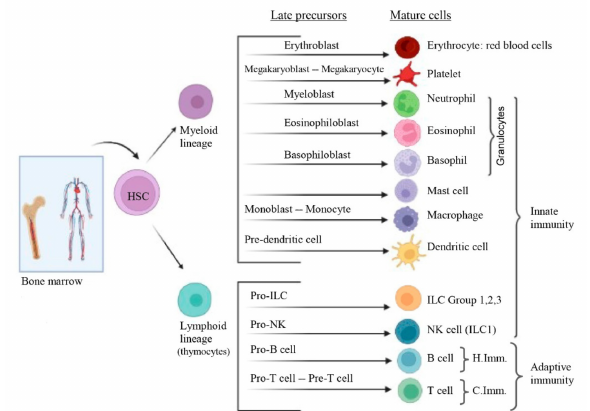
Figure 1. Hematopoiesis. The hematopoiesis process begins with the division of the hematopoietic stem cell (HSC), found in the bone marrow. This type of cell has the ability to be multipotent and self-renewing. HSCs, through the production of multipotent hematopoietic progenitor cells (HPCs) can give rise to two types of blood cell lines (myeloid and lymphoid lineage). Each of them, at the end of the process, will give rise to late precursors and mature cells forms through committed precursors. Mature cells are divided into three groups: red blood cells, platelets and leukocytes. Leukocytes form the innate and adaptive immunity, this latter subdivided in humoral (governed by B cells) and cellular immunity (by T cells). HSC: Hematopoietic stem cell; ILC: Innate Lymphoid Cell; NK cell: Natural Killer cell; H.Imm: Humoral immunity; C.Imm: Cellular